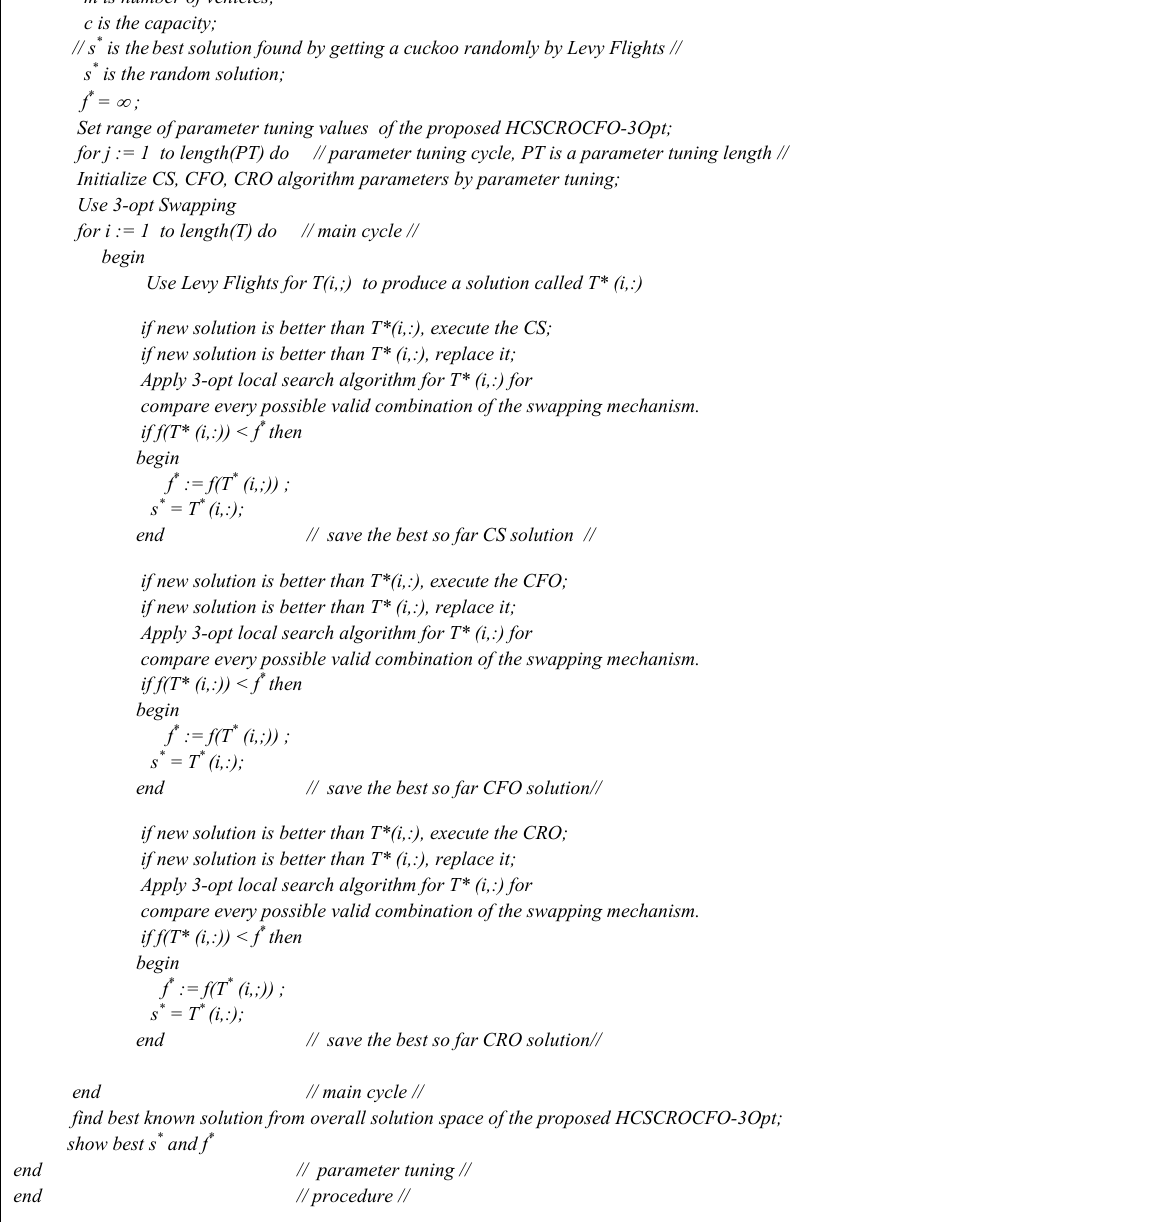
Fig. 3 shows the parameter tuning. The optimal parameters for the proposed HCSCROCFO-3Opt are shown for CS (0.7 for Alpha, 0.2 for Beta, 0.7 for Delta, and 0.5 for Gamma), CRO (9 for IKE, 9 for IPS, 1 for IBF, 10 for CRT, and 10 for LRT), and CFO (0.5 for Alpha, 0.7 for Beta). The replacement of the corresponding value with a new one is done subsequent to the validation that a fitting value is gotten for a particular parameter. After the replacement, the next step is to proceed to the next parameters with an amended